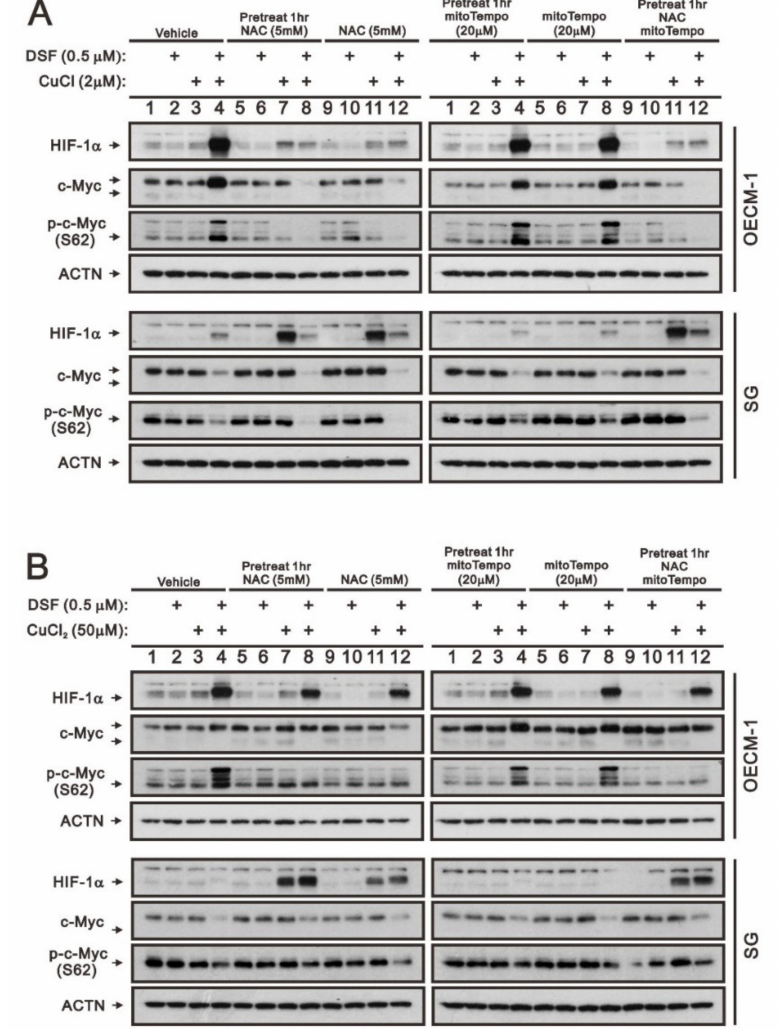
Figure 4. The effects of DSF, copper ions, and DSF/copper complexes on the c-Myc and HIF-1 α proteins by NAC and mitoTEMPO in OECM-1 and SG cells. OECM-1 and SG cells were treated with ( A ) 2 µ M of CuCl plus 0.5 µ M of DSF and ( B ) 50 µ M of CuCl 2 plus 0.5 µ M of DSF for 2 h (added indicated drugs labeled with +) in the presence of pretreated NAC, mitoTEMPO, or co-treated NAC with mitoTEMPO for 1 h. The cell lysates were subjected to Western blot analysis using antibodies against the indicated proteins. ACTN was a loading protein control. The results are representative of three independent